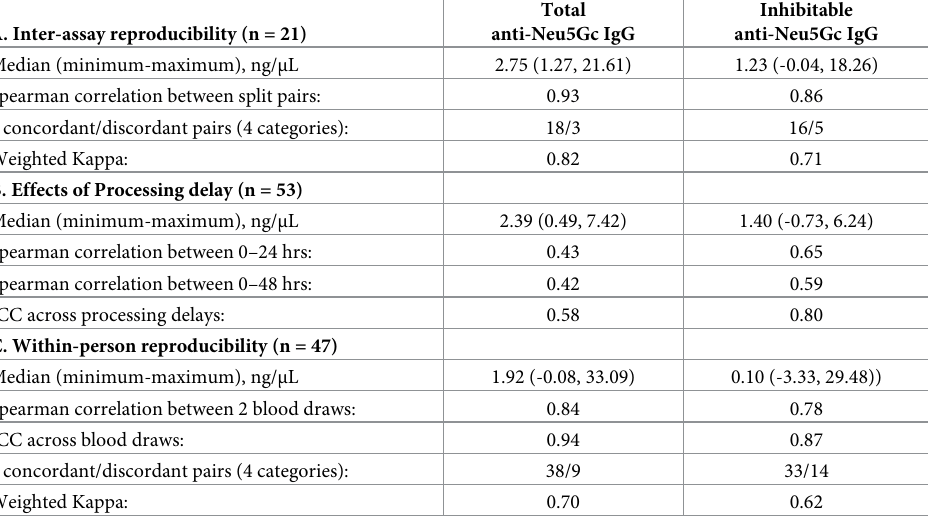
Table 4. Inter-assay reproducibility, effects of processing delay and within-person reproducibility in the NHS